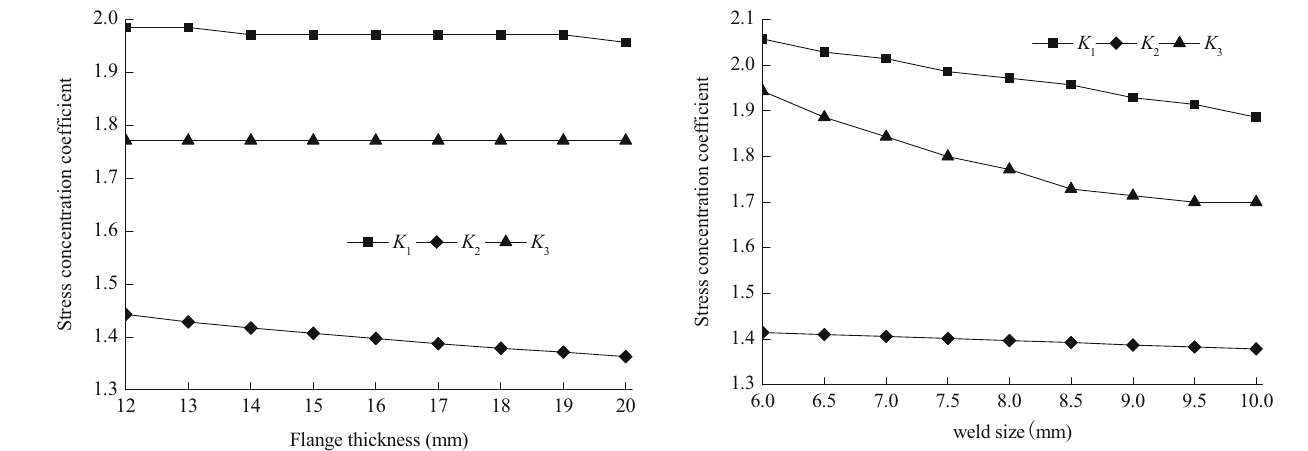
Fig. 8 Relationship between SCC and weld size